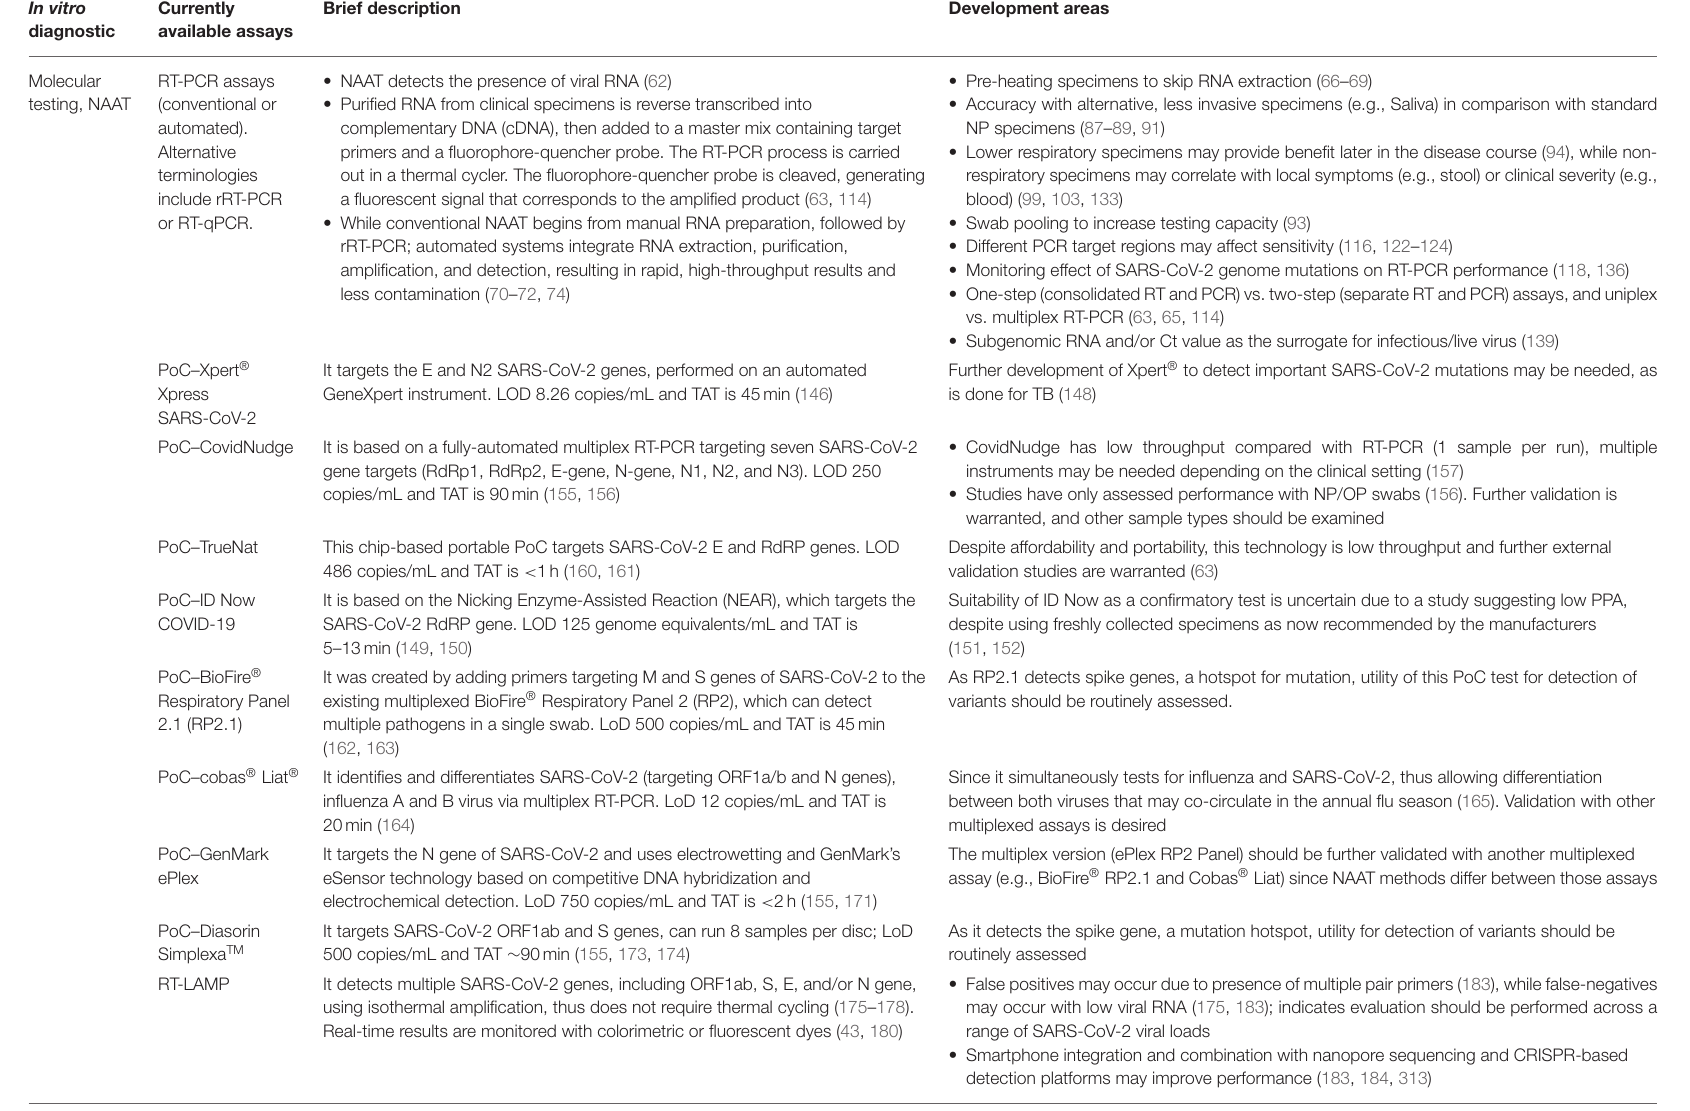
TABLE 1 | In vitro diagnostics for COVID-19 and potential areas for development. In vitro Currently Brief description Development areas diagnostic available assays Molecular testing,